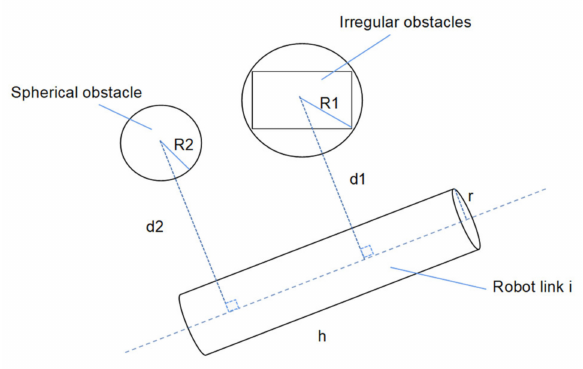
Figure 4. Collision detection